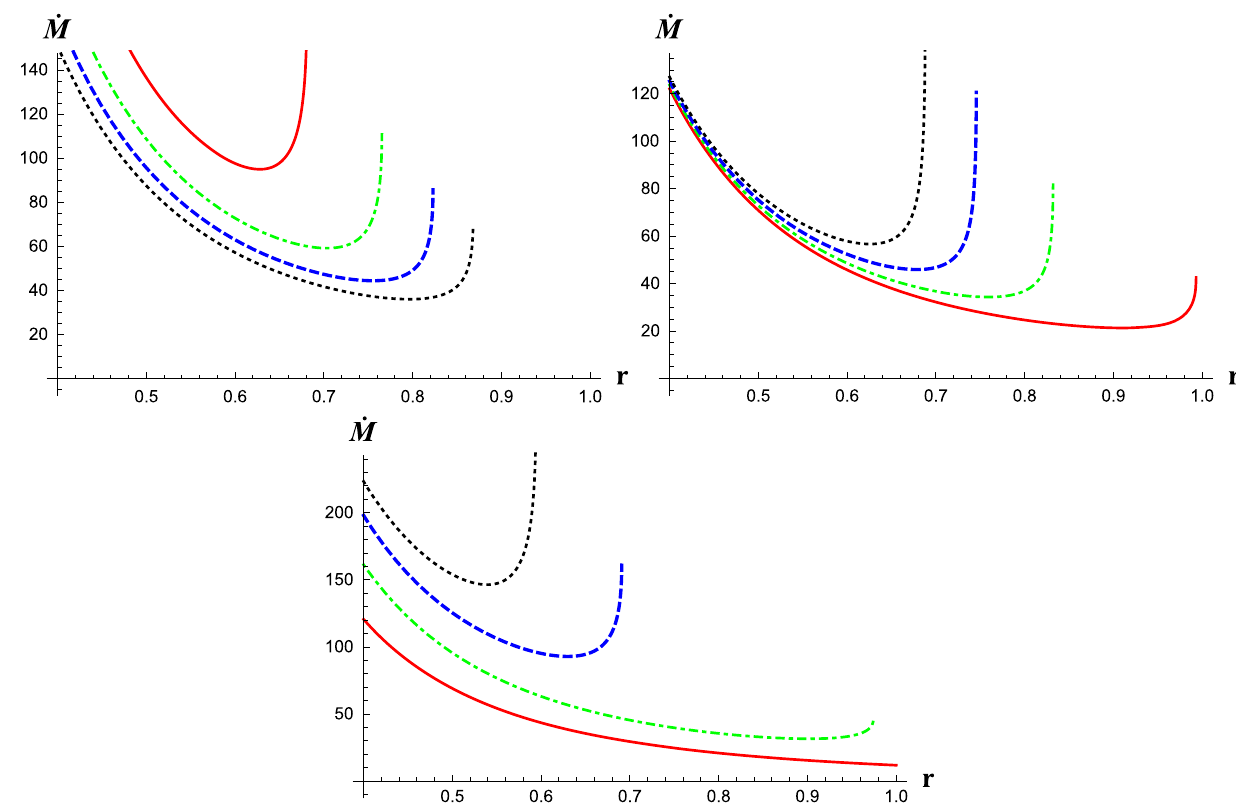
Fig. 10 For the mass accretion rate, left panel (conformal gravity BH) displays the behavior of Eq. (82) with conformal parameters γ = 0 . 1, k = − 1, β = 1. Right panel (Schwarzschild–de Sitter BH) displays the behavior of Eq. (83) with parameters γ = 0, k = − 1, β = 1.